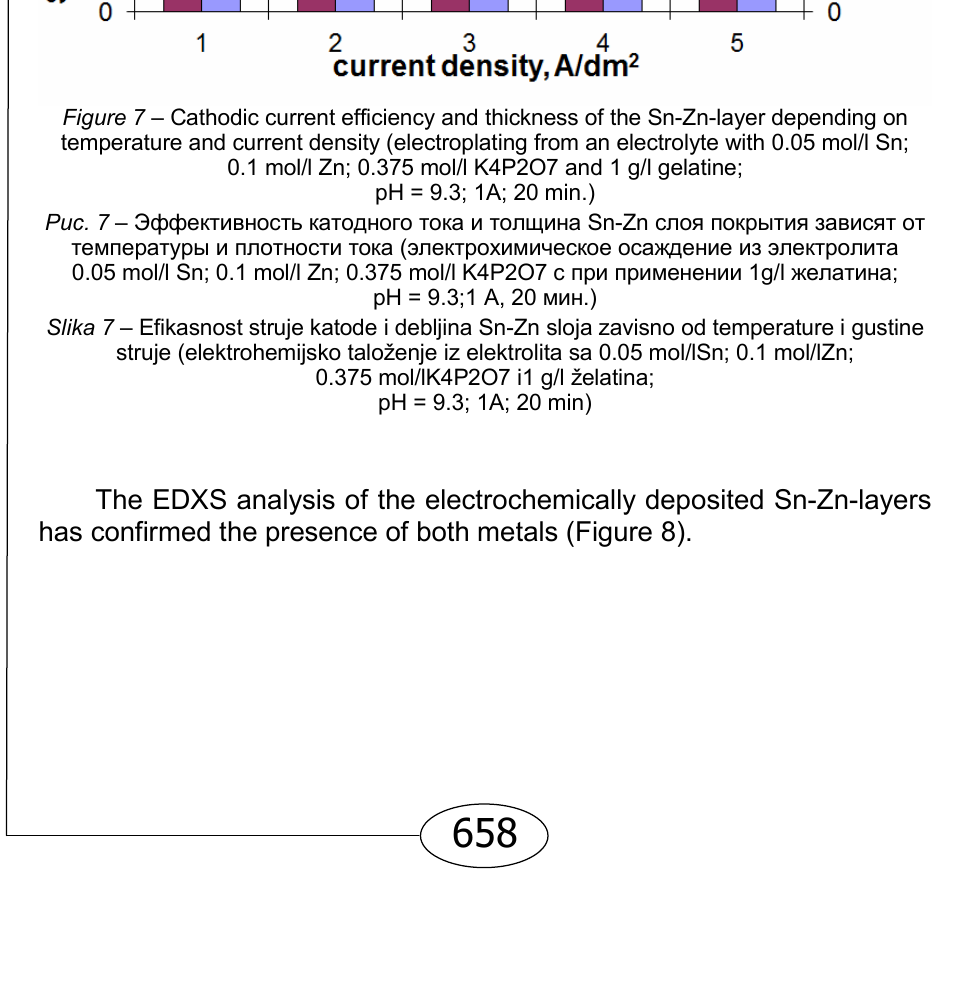
Figure 7 – Cathodic current efficiency and thickness of the Sn-Zn-layer depending on temperature and current density (electroplating from an electrolyte with 0.05 mol/l Sn;